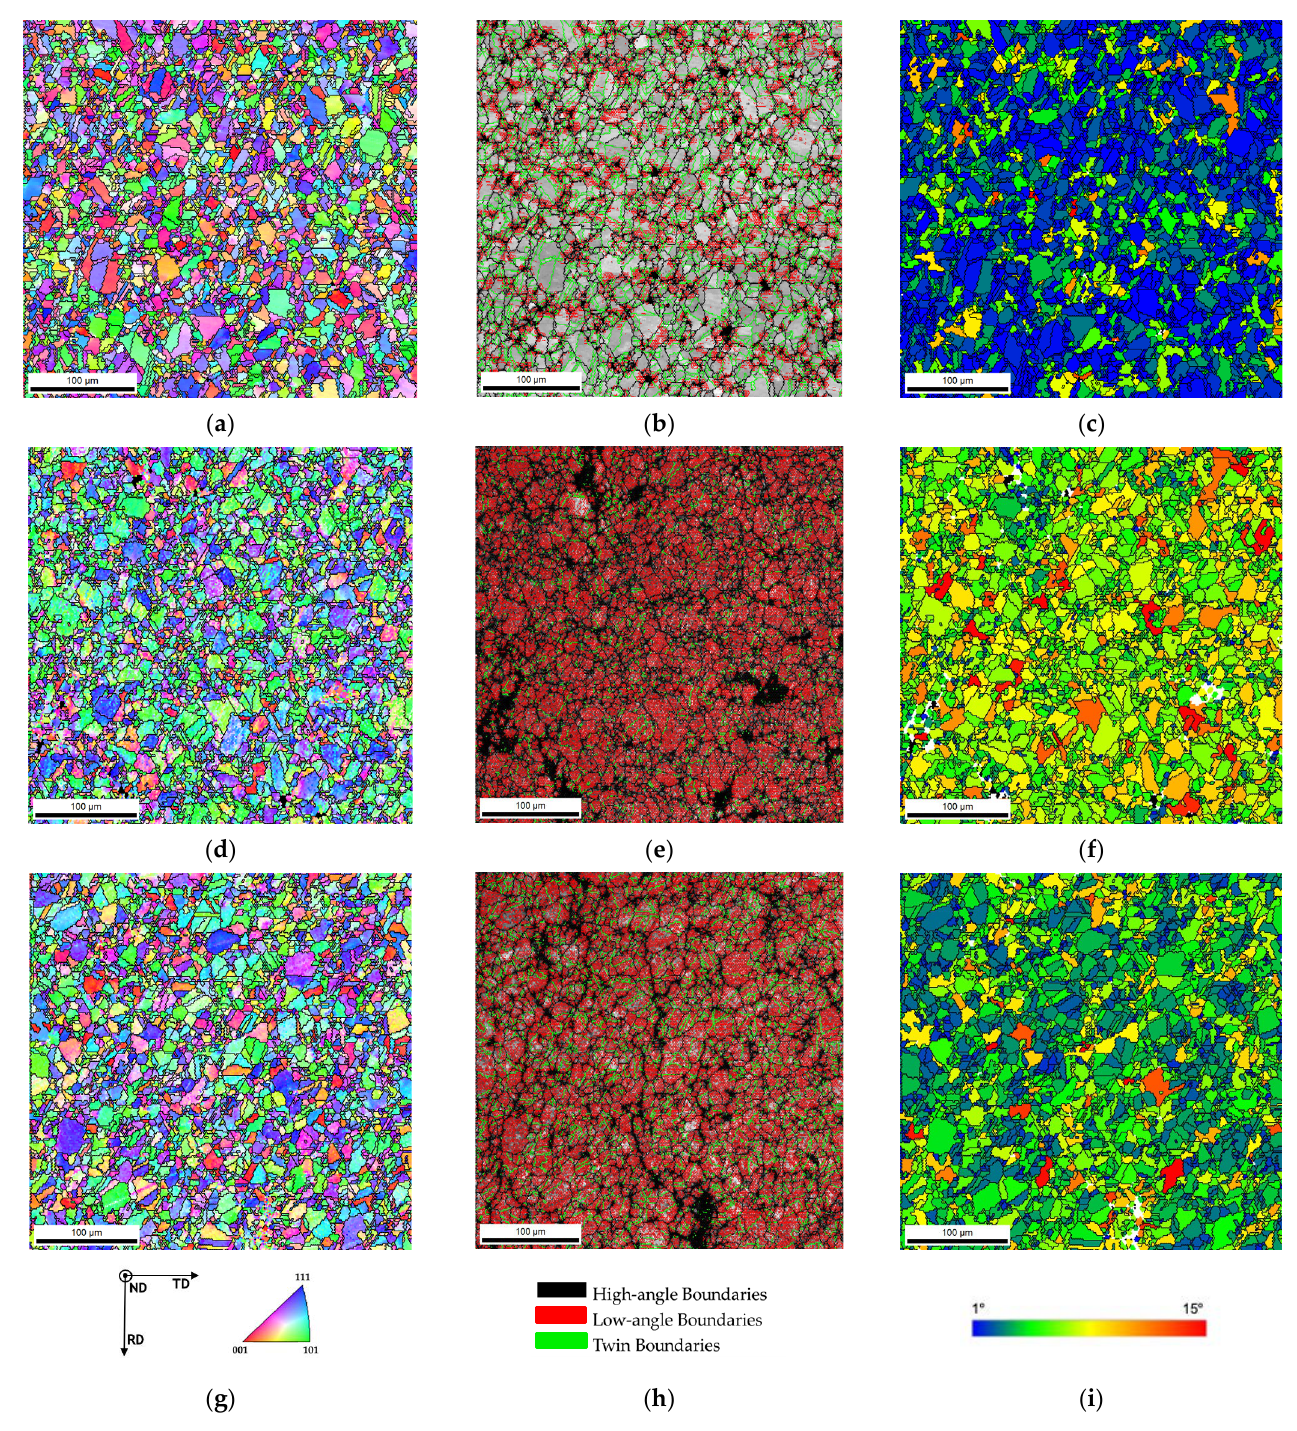
Figure 6. Inverse pole figure (IPF) map, image quality (IQ) with high- and low-angle boundaries and twin boundaries delineated, and grain orientation spread (GOS) maps of ( a – c ) Ni heat-treated at 700 °C for 120 min, ( d – f ) Ni-1.00 vol.% CNT heat-treated at 700 °C for 120 min, and ( g – i ) Ni-1.00 vol.% CNT heat-treated at 1100 °C for 30 min. IPF maps indicated that the nanocomposites revealed more grains corresponding to the (101) planes (green grains) on the heat-treated samples than the Ni matrix. This means that the crystalline orientation for the nanocomposites is different, so the CNTs affect the grain rotation during the heat treatment. Figure 7 shows the inverse pole figure graphs for the samples with and without CNT heat-treated at 700 and 1100 °C. These images